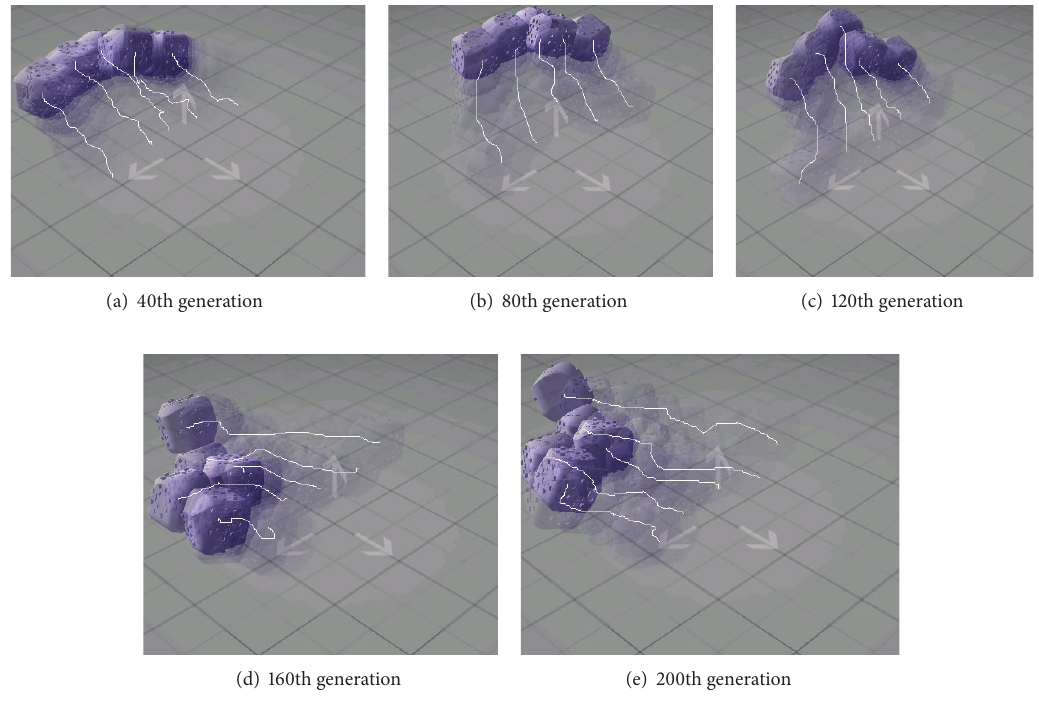
Figure 13: The movement traces of the proposed system as generation